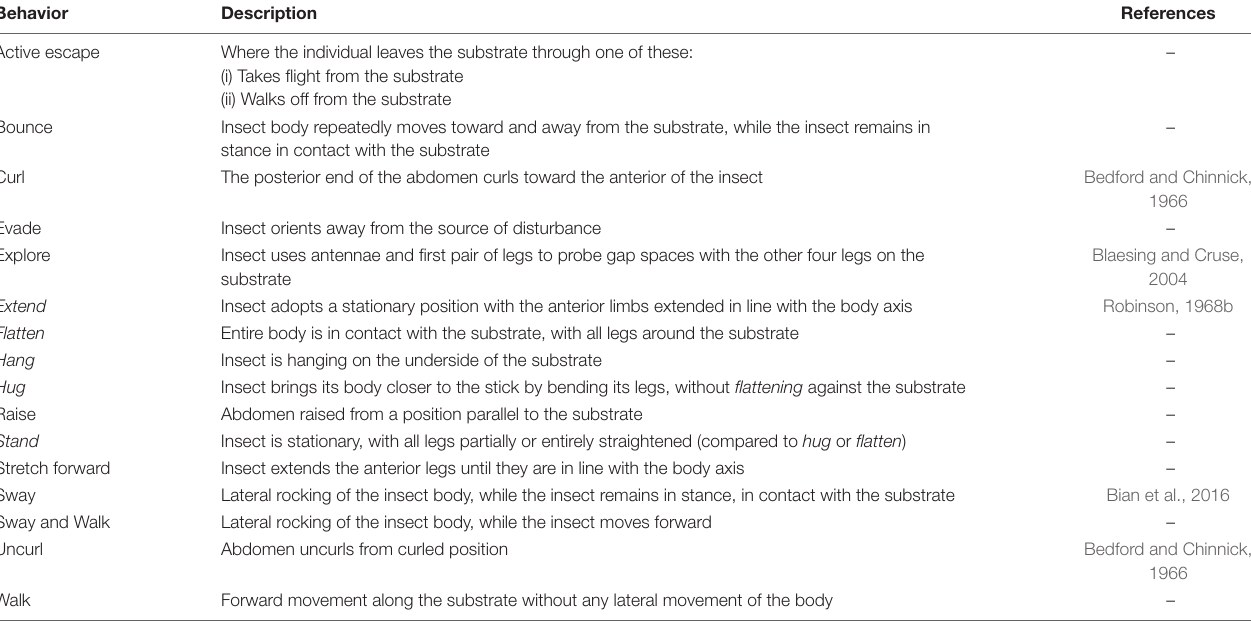
TABLE 1 | List of scored behaviors and their